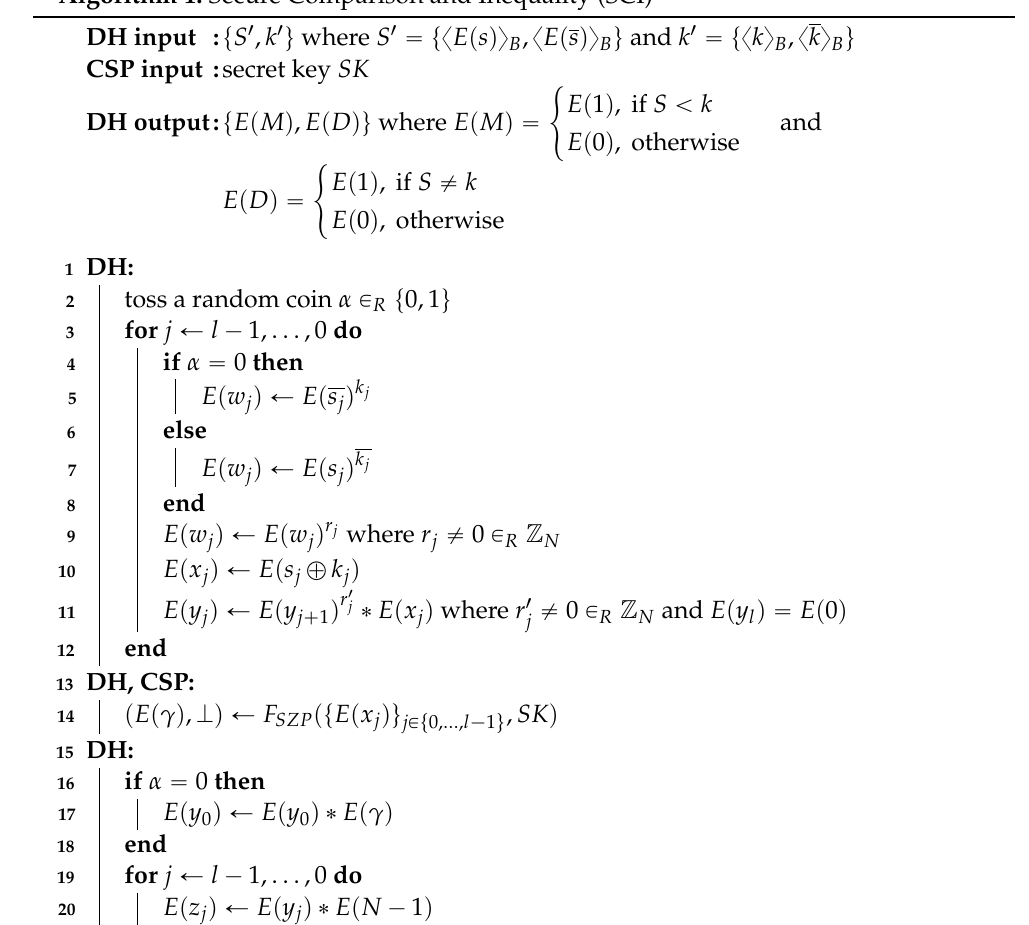
Algorithm 1: Secure Comparison and Inequality